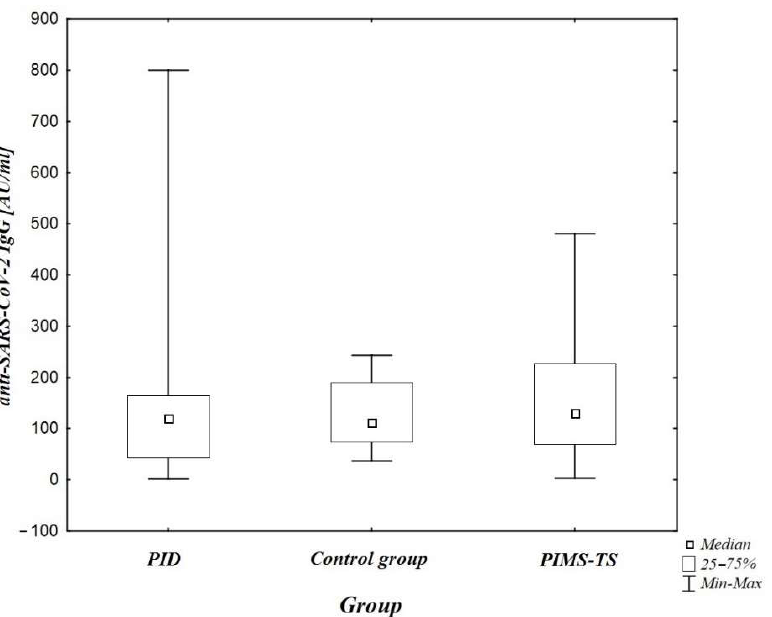
Figure 2. A comparison of anti-SARS-CoV-2 IgG antibody levels in patients with confirmed or highly probable COVID-19 in each patient group ( p > 0.05). PID-primary immunodeficiency; PIMS-TS-paediatric inflammatory multisystem syndrome.